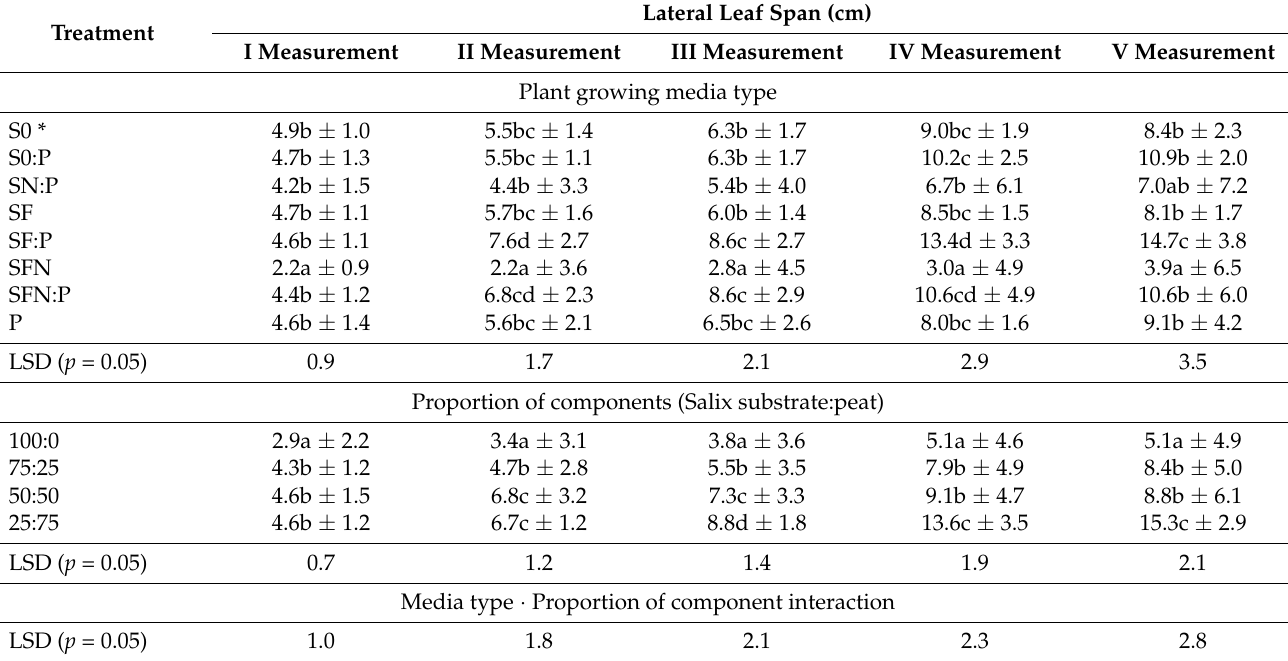
Table 4. The effect of horticulture media on lateral leaf span (average ± standard